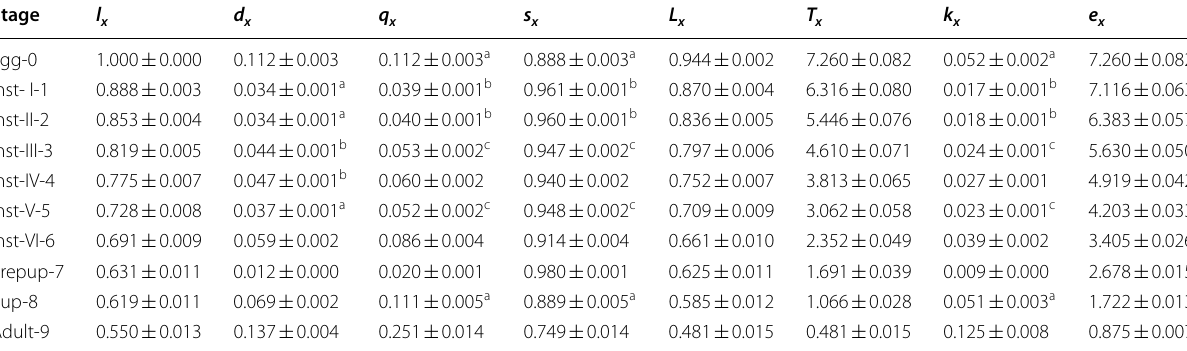
Within the column means followed by same letter(s) are not significantly different at P < 0.05 by Tukey’s (HSD)